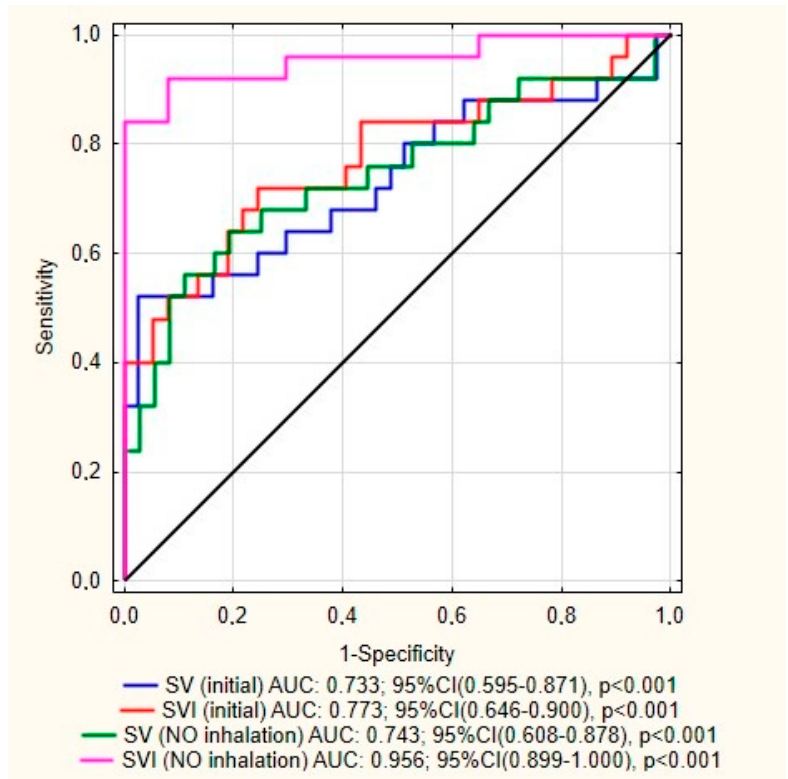
Figure 1. Comparison of ROC curves of dependency between SV along with SVI (obtained during initial measurements and iNO inhalation) and end points occurrence in five-year follow-up. Table 7. Receiver operating characteristic curve analysis results. algorithm have shown that only SVI (NO test) and SaO 2 are independent predictors of worse prognosis. Both higher SVI (NO test) by 1 mL and resting SaO 2 by one pp were connected with a 9.00% probability reduction of death or lung transplantation in five-year follow-up (Table 8).